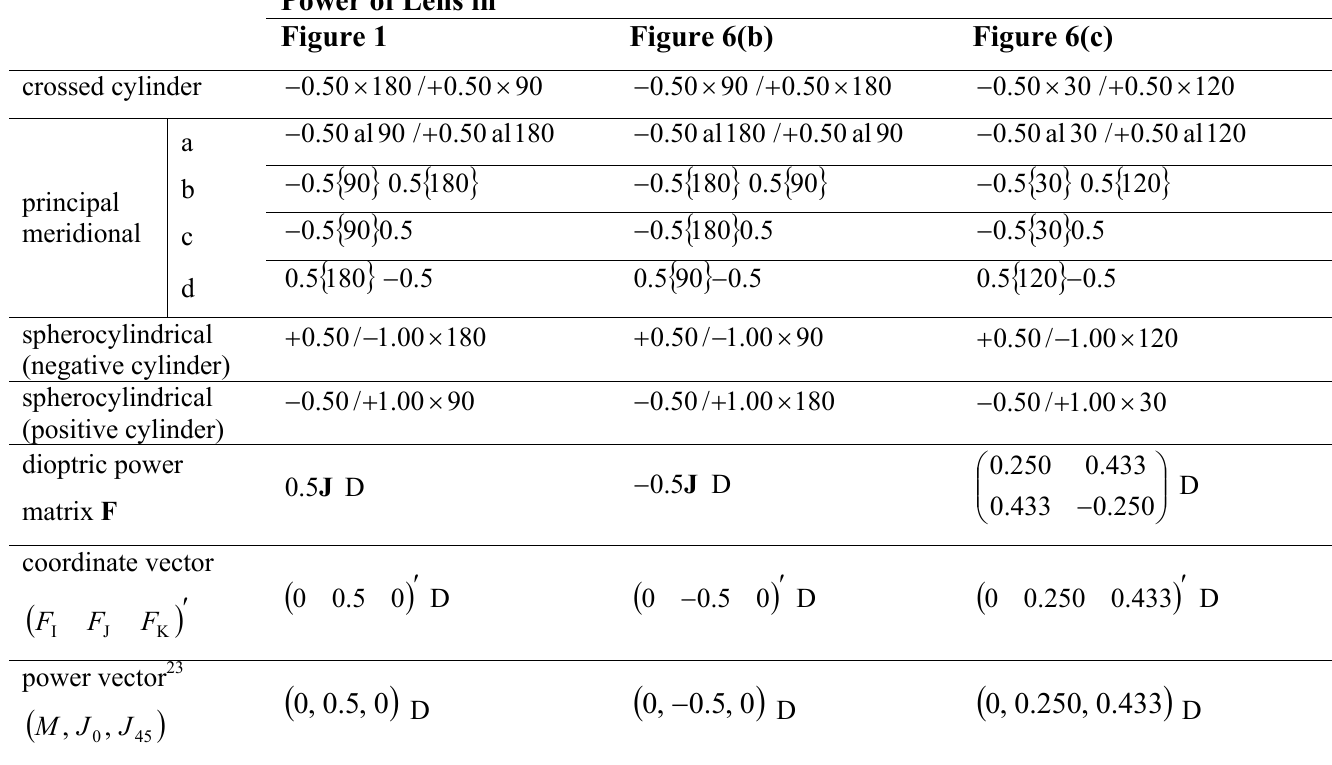
Table 1 Some representations of the powers of Jackson